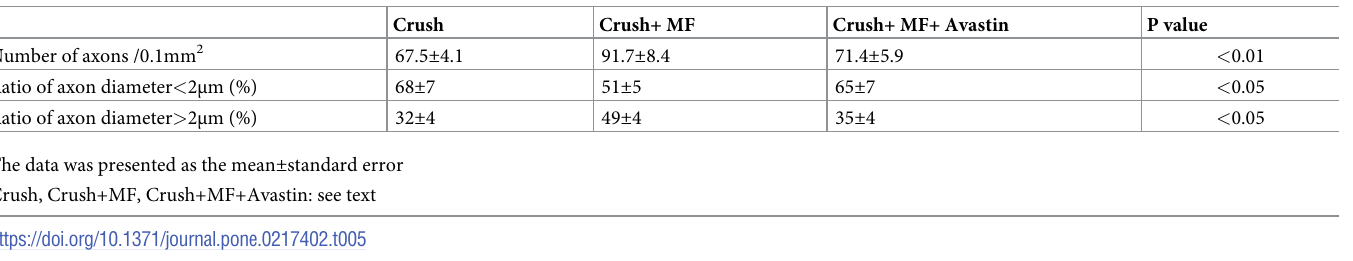
S1 Fig. Depiction of inflammatory response in crushed nerve by the muscle flap rotation and Avastin injection. (A) The illustration of CD 68 distributed in crushed nerve subjected to various treatments. (B) A representative of western blot showing expression of CD 68 in the various treatment groups. (C) Quantitative analysis of CD 68 in the various treatment groups.